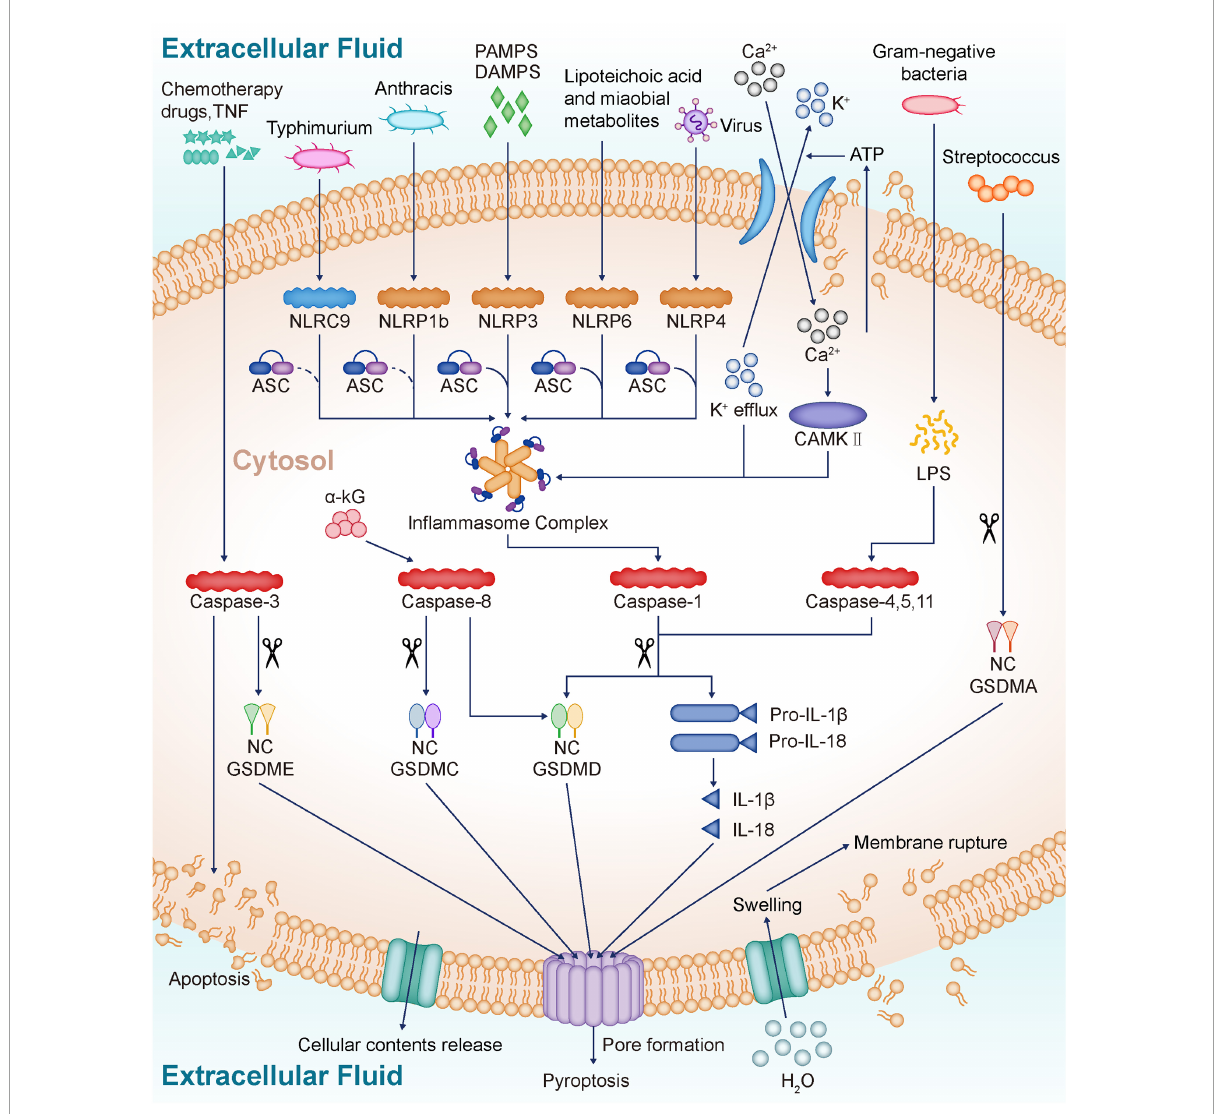
FIGURE1 Profiles of pyroptosis. NLR proteins sense various danger signals inside and outside the cell and then activate caspase-1, which eventually leads to pyroptosis and release of inflammatory cytokines IL-18 and IL-1 β . NLRC4 recognizes Typhimurium, NLRP6 recognizes lipoteichoic acid and Microbial metabolites, NLRP9 recognizes Virus, and after recruitment of ASC, eventually forms inflammasome. The inflammasome prompt caspase-1 activation, and the activated caspase-1 cleaves the GSDMD to release the GSDM N-terminal, which forms a non-selective pore in the plasma membrane through oligomerization. The formation of non-selective channels leads to membrane rupture, and IL-18 and IL-1 β release, ultimately inducing pyroptosis. LPS released from gram-negative bacteria directly activates caspase-4, 5, and 11, which cleave GSDMD, ultimately leading to pyroptosis and inflammatory mediator release. α -KG induces pyroptosis via caspase-8-mediated GSDMC cleavage. In addition, caspase-8 also mediates the cleavage of GSDMD. Chemotherapy drugs and TNF activate caspase-3, which cleaves GSDME and induces pyroptosis. Streptococcus induces pyroptosis by direct shearing of GSDMA. ATP from damaged cells is released into the extracellular space, activating P2 × 7R, which promotes K + efflux and Ca2 + influx. The inward flow of Ca2 + activates CAMKII, which eventually activates inflammasome and induces pyroptosis. NLR, NOD-like receptors; IL-18, Interleukin-18; IL-1 β , Interleukin-1 β ; NLRP3, NOD-like receptor protein 3; PAMPS, Pathogen-derived mediators; DAMPS, Endogenously generated mediators; NLRP1b, NOD-like receptor protein 1b; NLRC4, NOD-like receptor protein 4; NLRP6, NOD-like receptor protein 6; NLRP9, NOD-like receptor protein 9; ASC, Apoptosis-associated speck-like Protein; GSDMD, Gasdermin D; LPS, Lipopolysaccharide; α -KG, α -ketoglutarate; GSDMC, Gasdermin C; TNF, Tumor necrosis factor; GSDME, Gasdermin E; GSDMA, Gasdermin A; ATP, Adenosine triphosphate; P2 × 7R, P2 × 7 receptor; CAMKII, Calmodulin kinases